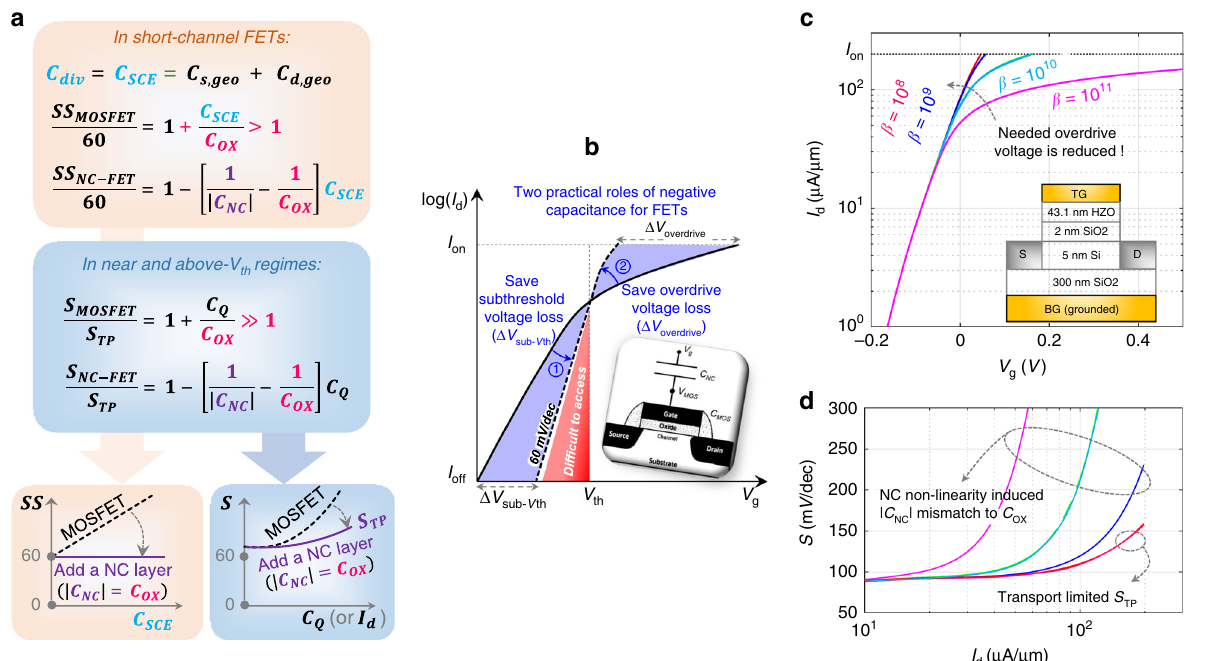
Fig. 4 Role for NC in MOSFETs as a voltage-loss saver. a With a simple | C NC | = C OX matching, SS can be restored to 60 mV per decade in short-channel MOSFETs, and S in near- and above- threshold regimes can be reduced to the transport limit ( S TP ). Here C trap and C dep are neglected, since they have been greatly suppressed in state-of-the-art MOSFETs. Thereby, b NC layer can help suppress the short-channel effect induced subthreshold voltage loss ( Δ V sub- Δ V fi cult for NC to help obtain hysteresis-free steep-slope turn-on overdrive ). It is dif Vth ), and inversion charge screening induced overdrive voltage loss ( characteristics. c Simulated I d – V g and d S versus I d curve of a Si SOI NC-FET in which | C NC | is matched to C OX . Lower NC non-linearity (quanti fi ed by the factor of β ) is desired, in terms of restoring S back to S TP